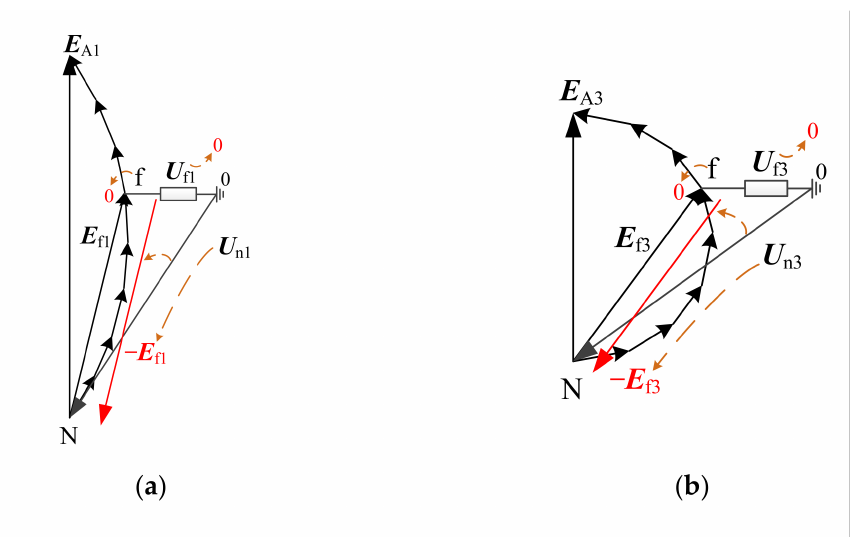
Figure 2. Phasor diagram under voltage regulation. ( a ) Phasor diagram under fundamental voltage regulation. ( b ) Phasor diagram under third-harmonic voltage